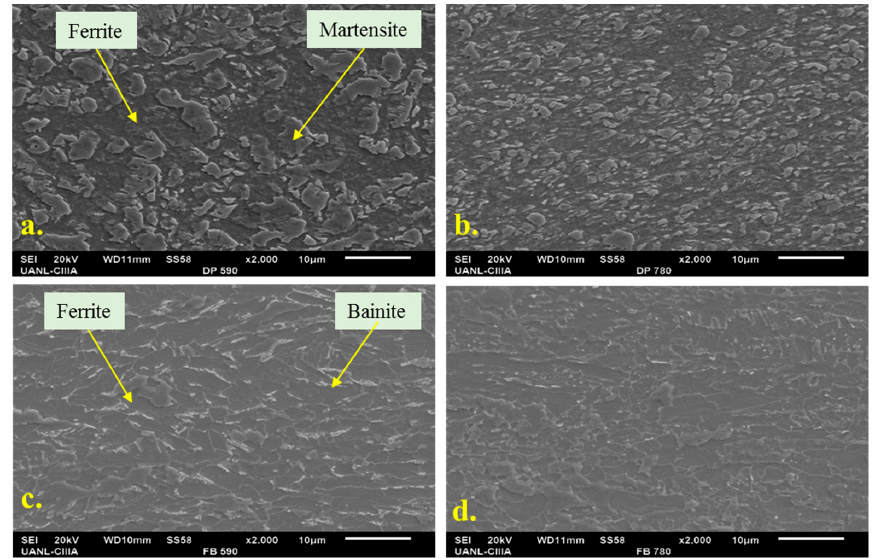
Figure 1. Scanning electron microscopy (SEM) microstructures of ( a ) DP590, ( b ) DP780, ( c ) FB590 and ( d ) FB780 steels.